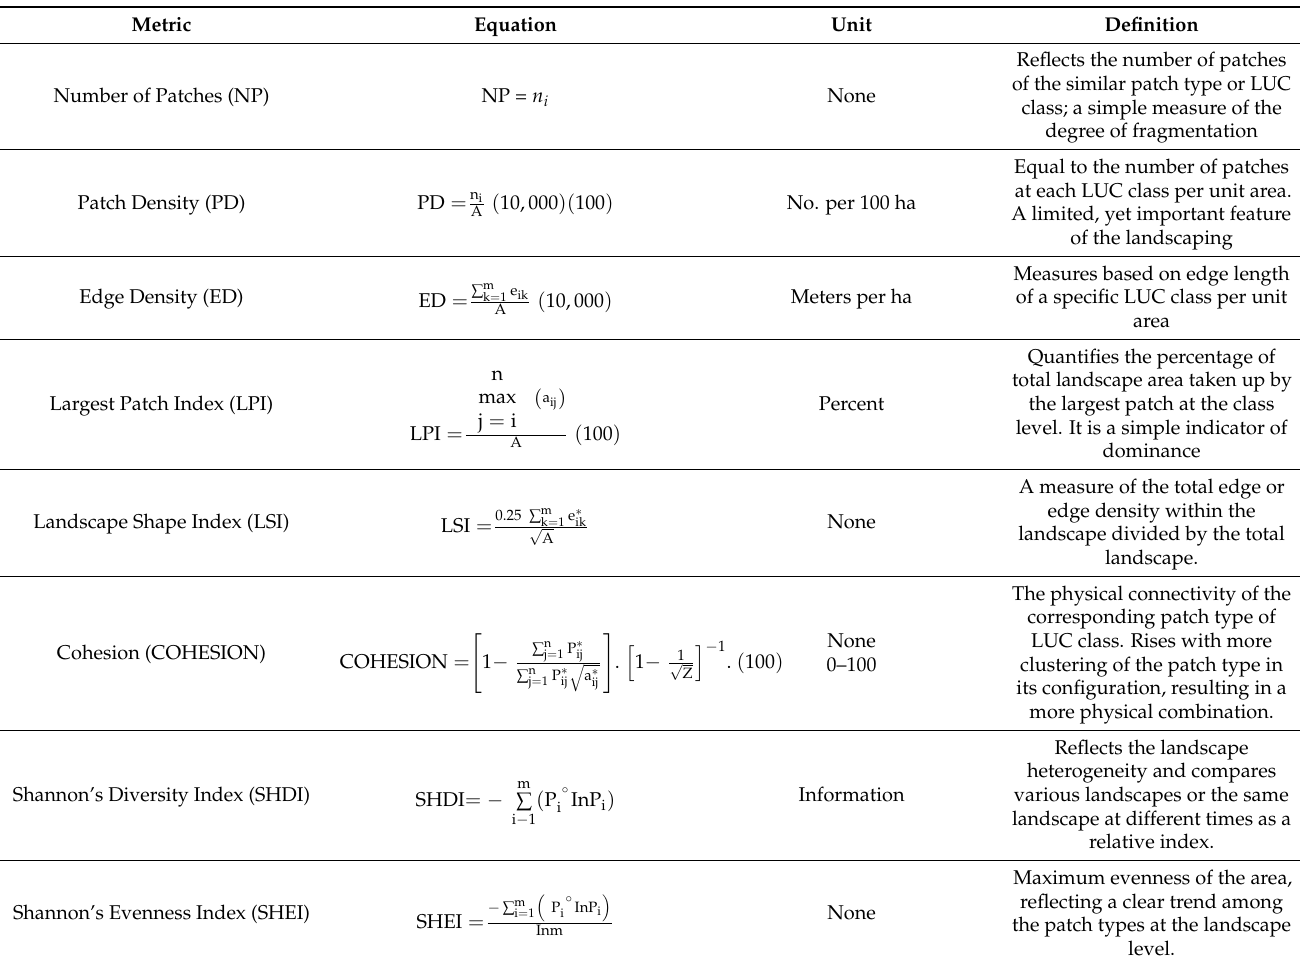
Table 2. Class and landscape-level spatial metrics